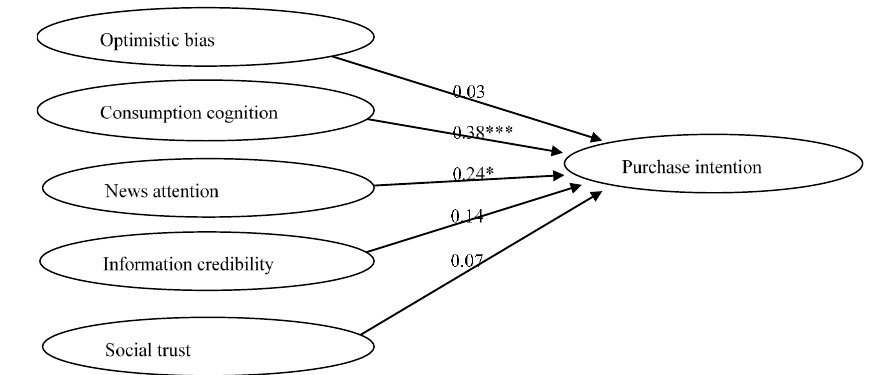
Figure 3. Path coefficient results of alternative model of the mainland China sample. Note: (1) *** p < 0.001, * p < 0.5; χ 2 = 1723.19; df = 485; χ 2 /df (NC) = 3.55; CFI = 0.94; RMSEA =